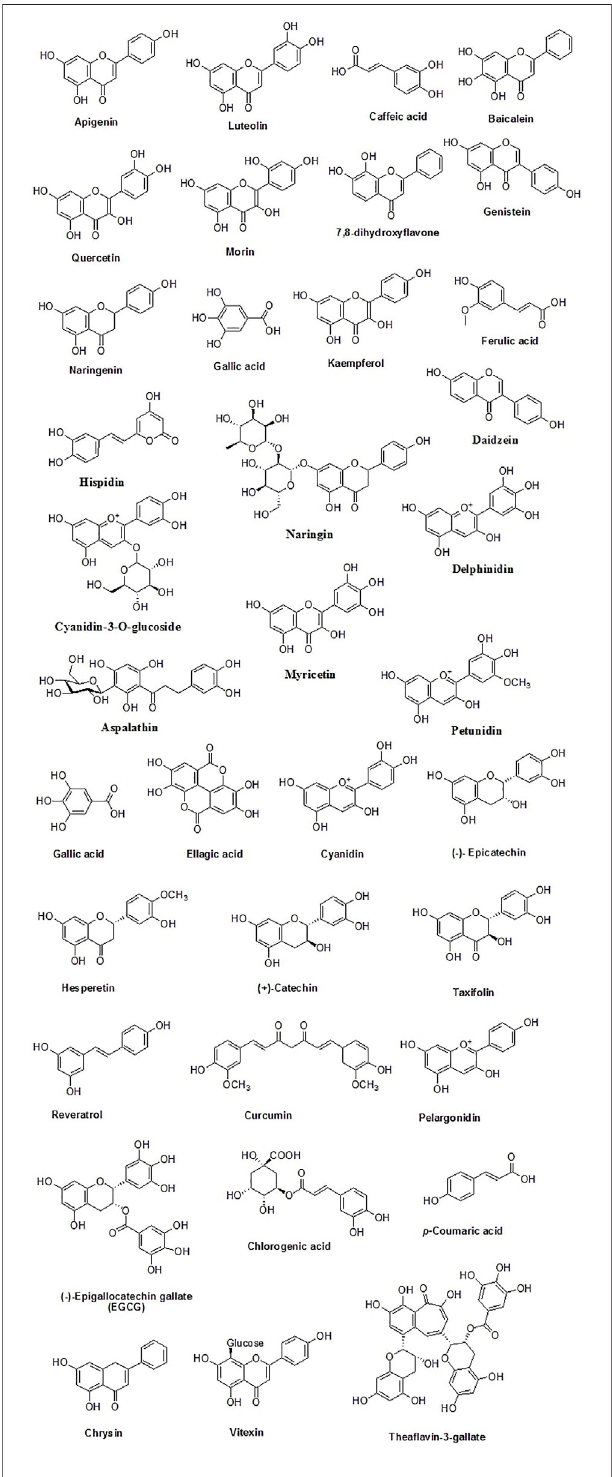
FIGURE 4 | Chemical structures of some common dietary polyphenols of medicinal importance.